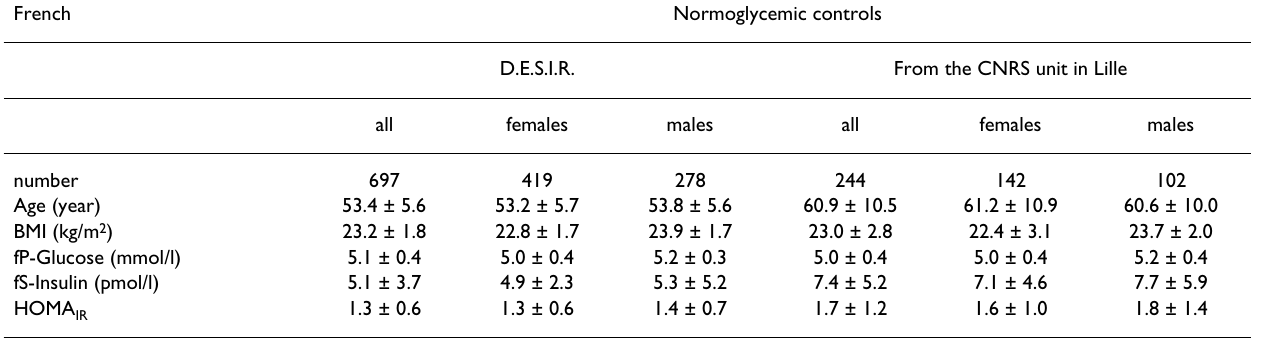
Table 4: Phenotypic distribution of cohorts French